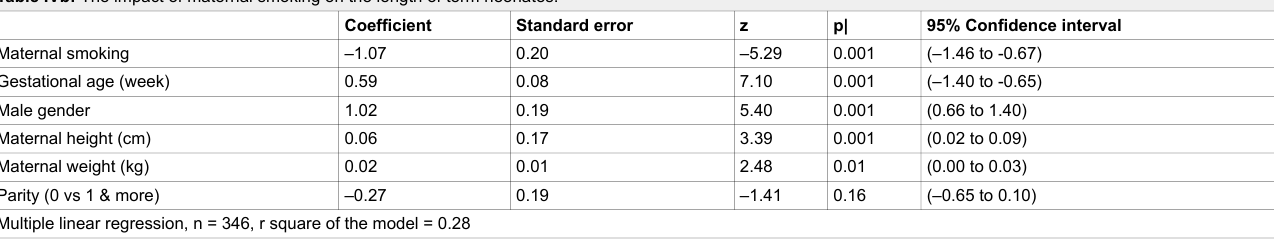
Table IVb: The impact of maternal smoking on the length of term neonates.